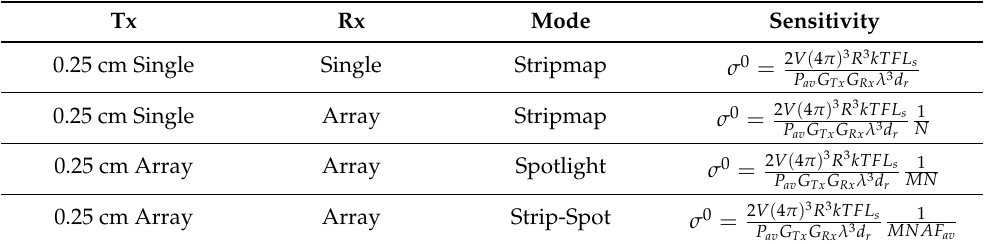
Table 3. The sensitivity formulas for different antennas and SAR